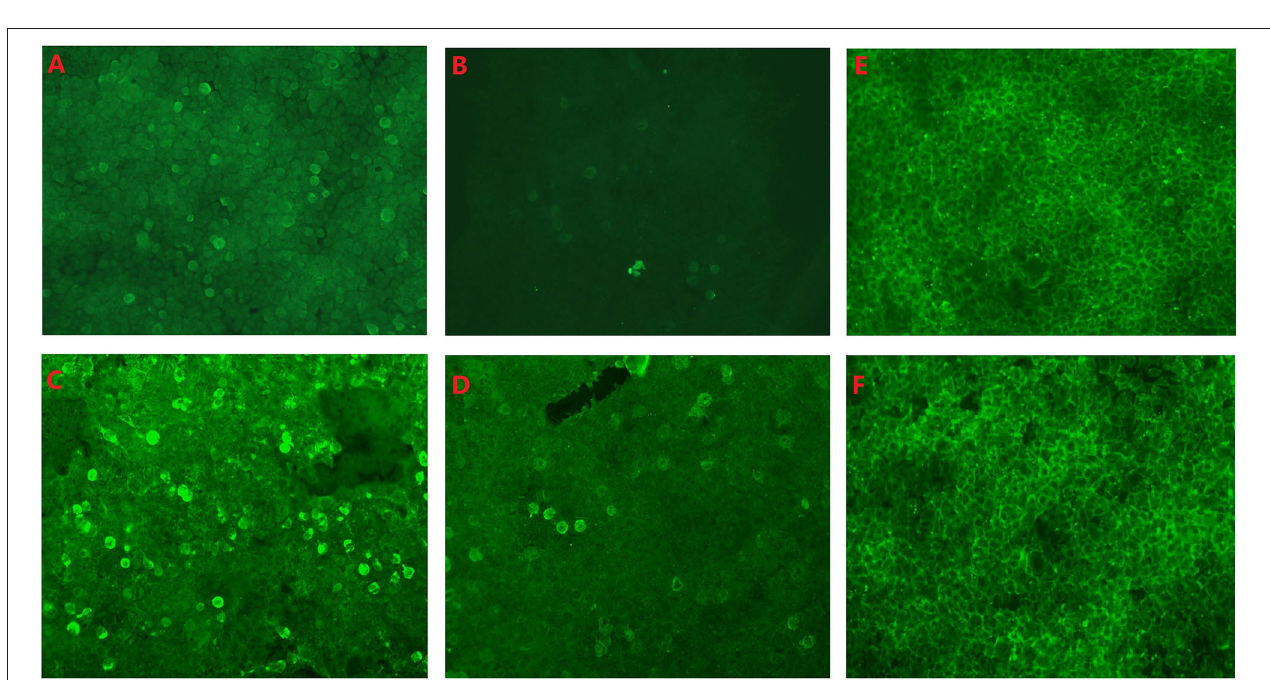
FIGURE 3 | (A) Anti-dipeptidyl–peptidase–like protein 6 (anti-DPPX) antibody titers in serum in fifixed HEK293 cells from patient 3: 1:10. (B) Anti-DPPX antibody titers in cerebrospinal fluid (CSF) in fifixed HEK293 cells from patient 3: 1:1. (C) Anti-DPPX antibody titers in serum in fifixed HEK293 cells from patient 4: 1:100. (D) Anti-contactin-associated protein-like 2 antibody titers in serum in fifixed HEK293 cells from patient 4: 1:10. No antibody in CSF (E) and serum (F) was observed in fifixed HEK293 cells form the control slide. All antibodies in CSF and serum were measured using indirect immunofluorescence technique (Euroimmun kits, Germany).